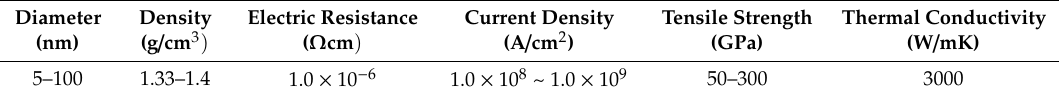
Figure 1. Schematic of concrete beam. Table 2. Features of CNT.